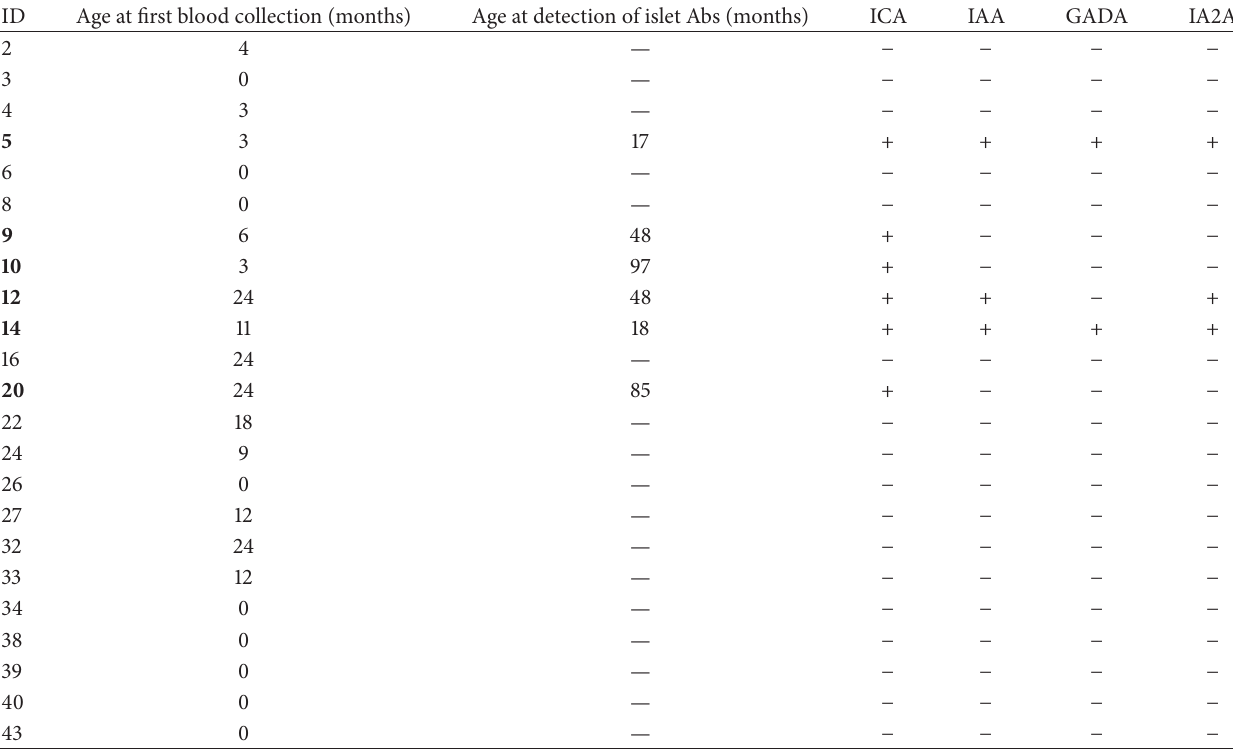
Table 1: Demographic characteristics and pattern of islet autoantibodies in T1D at-risk